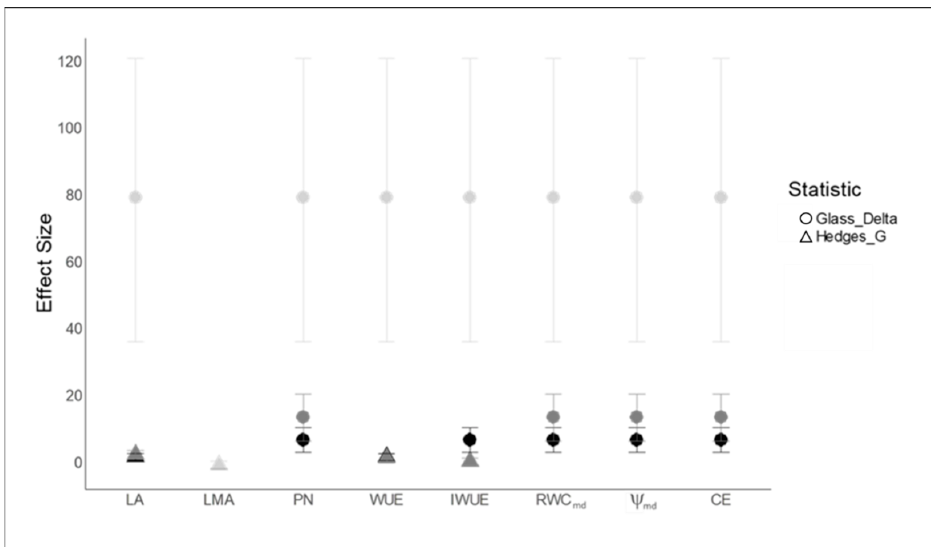
Figure 4. Effect size of the experimental treatments over trait expression. Leaf area (LA), leaf mass per area (LMA), net photosynthetic rate (P N ), water use efficiency (WUE), intrinsic water use efficiency (IWUE), midday relative water content (RWC md ), midday leaf water potential ( ψ md ), and apparent carboxylation efficiency (C E ). Dots and error bars are Hedges’ g and Glass’s delta and 95% confidence intervals, averaged for the several species and water stress statuses. The effect size refers to the responses between the control (i.e., first) and the end of the experiment (i.e., ninth). Ailanthuss altissima (AA) (black symbols), Phytolacca americana (PA) (grey symbols), and Robinia pseudoacacia (RP) (light grey symbols).